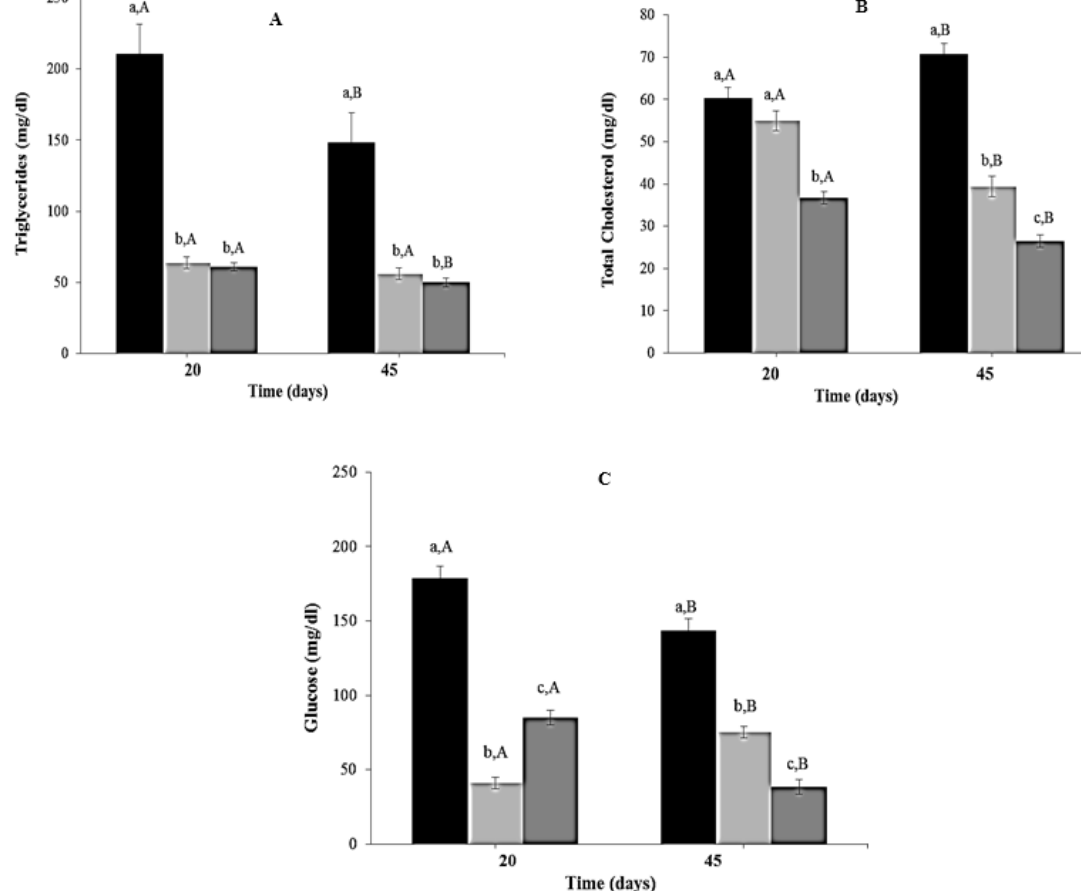
Figure 5. Biochemical parameters in plasma of ad libitum fed and caloric restricted mice, ( (cid:4) ) ALF Group: ad libitum fed, ( (cid:4) ) CR Group: caloric restriction, and ( (cid:4) ) CR-Lf Group: caloric restriction plus L. fermentum CRL1446: ( A ) Triglycerides; ( B ) Total cholesterol; and ( C ) Glucose. Bars represent the mean ˘ SEM, n = 12 per group. Data with different lowercase letters (a–c) at the same period of treatment and data with different uppercase letters (A,B) in the same group are significantly different ( p < 0.05) according to ANOVA statistical